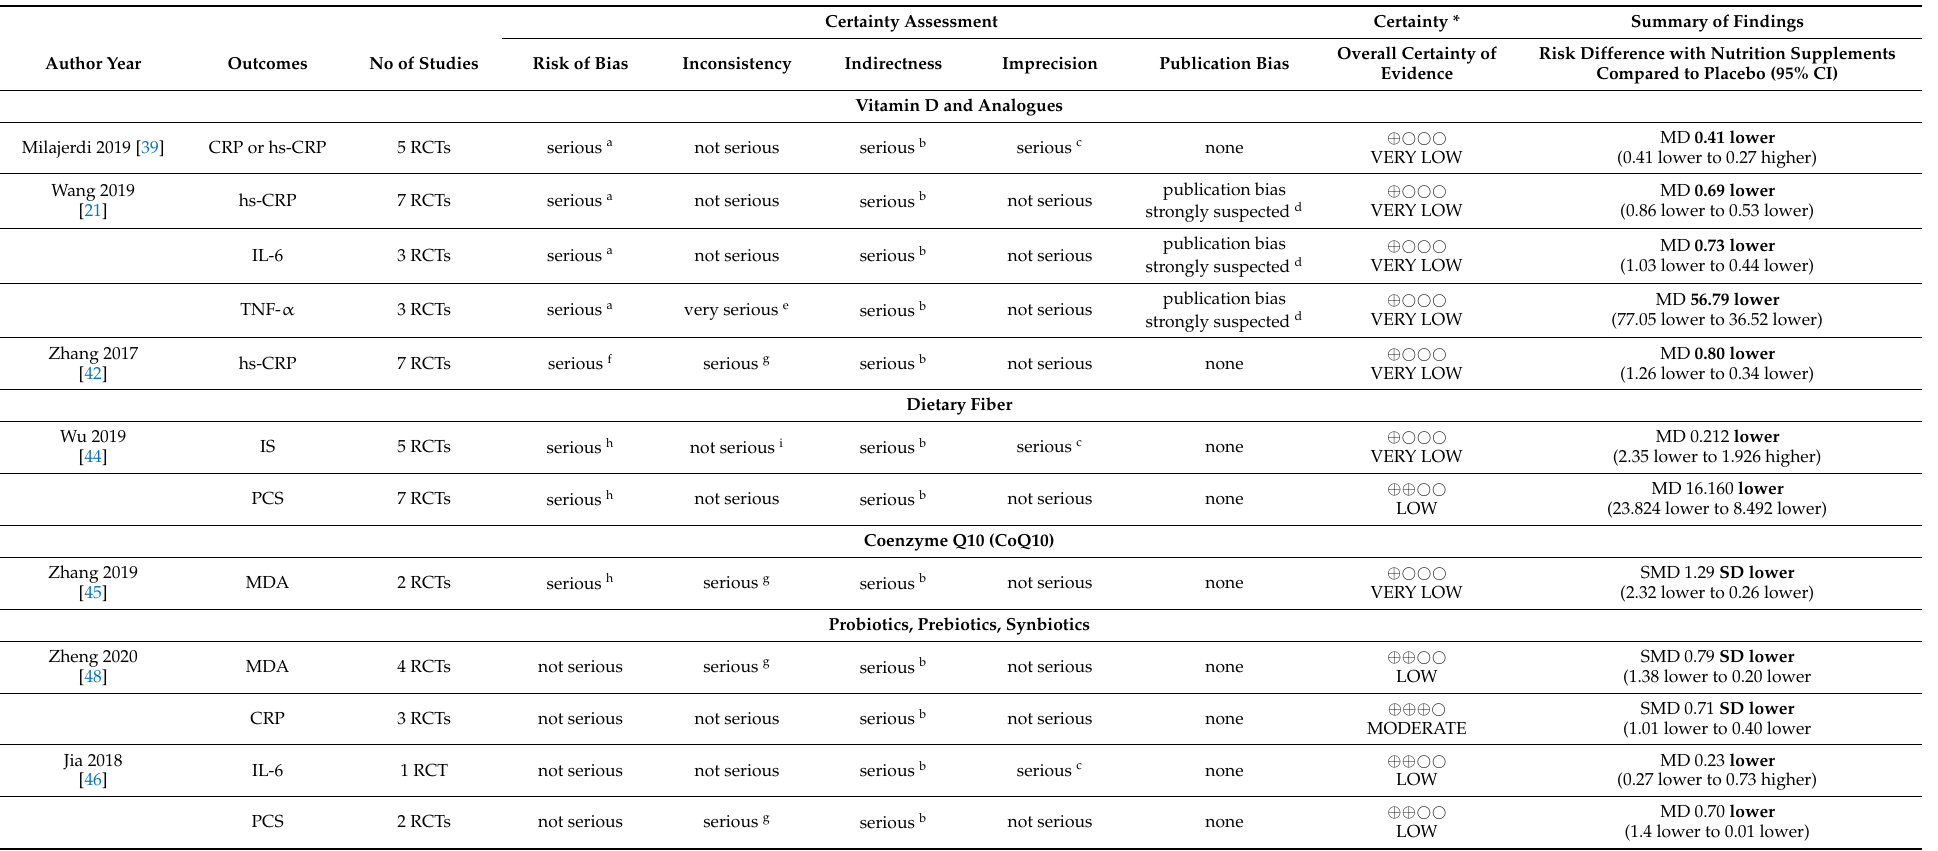
Table 3. GRADE approach evidence certainty and summary of findings of the surrogate